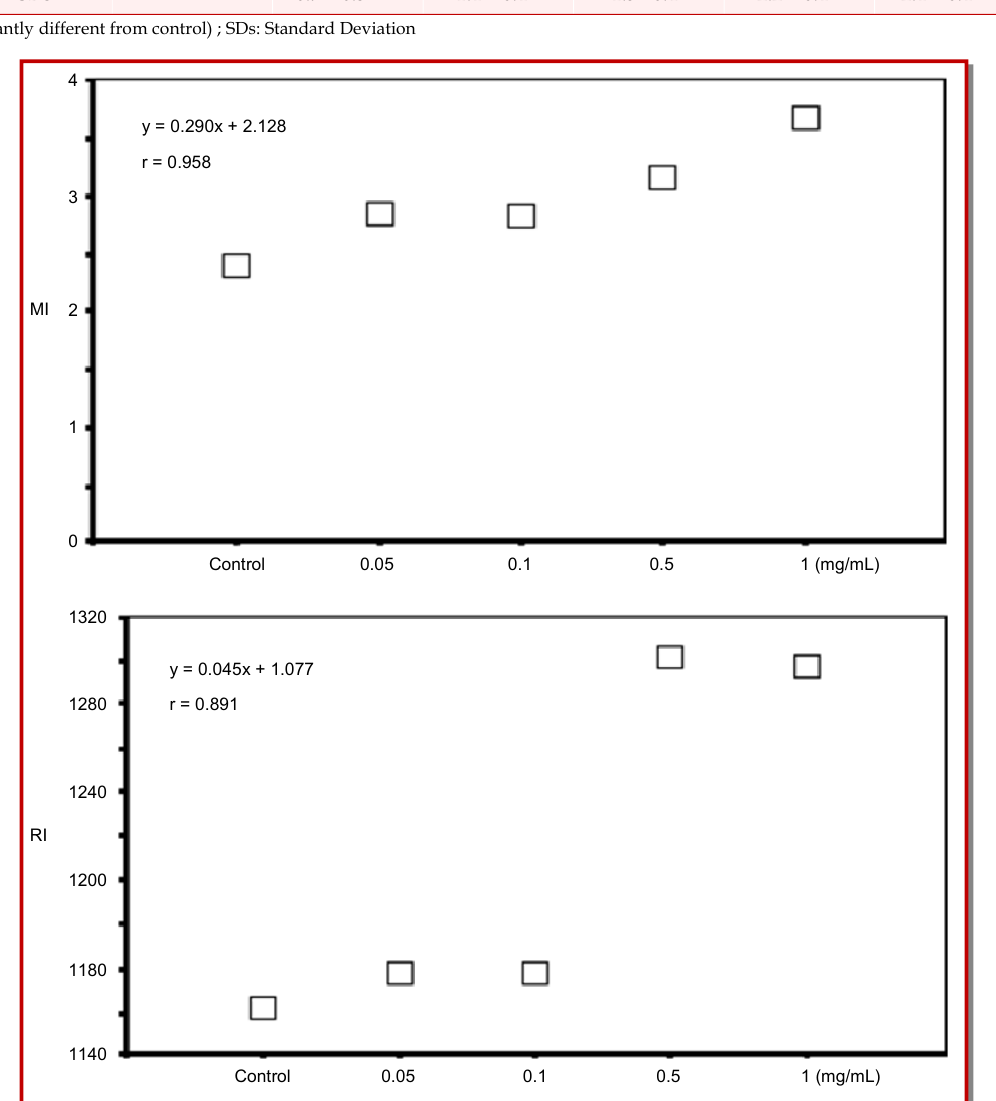
Figure 1: The positive correlations between mitotic index and the extract concentrations, replication index and the extract con-